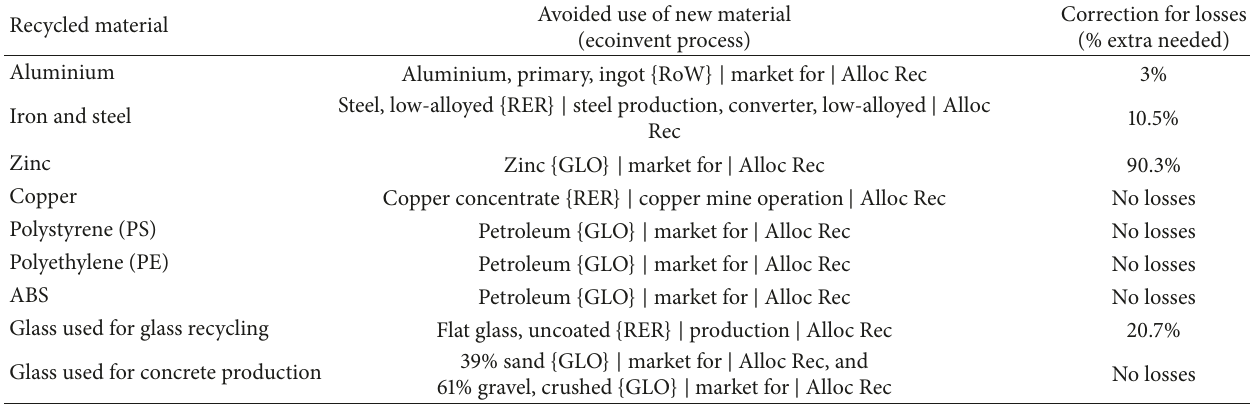
Table 1: Avoided use of new material and the associated correction for losses per recycled material. Recycled material